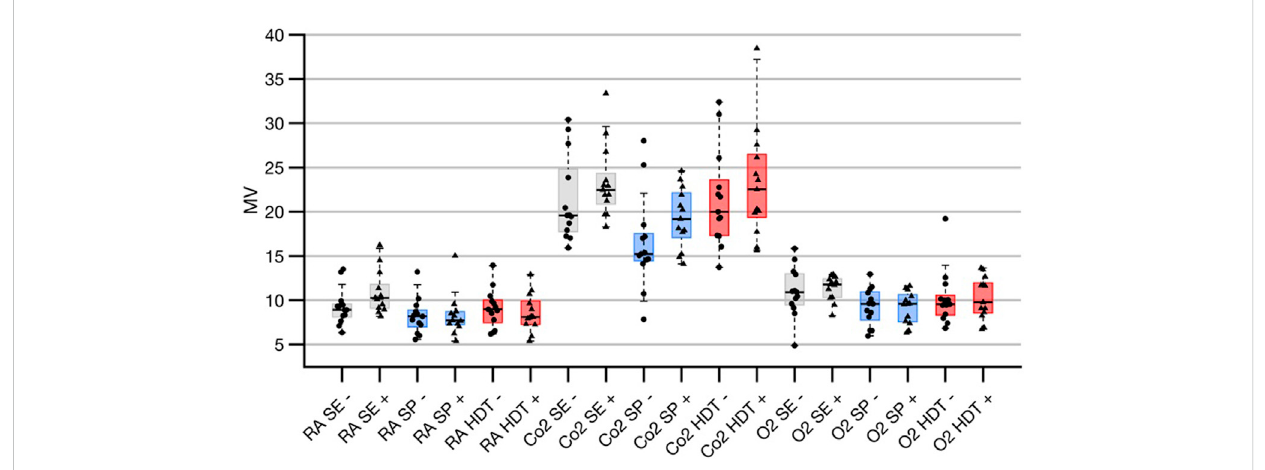
FIGURE 4 Results of 3-way ANOVA of minute ventilation derived from variation of three different factors, (A) TES (electrical stimulation on/off), (B) posture (seated, supine, HDT), and (C) inspired gas (room air, hypoxic and hypercapnic conditions). For further details of group assignments please refer to Supplementary Table S4. There was a signi fi cant interaction between factor b and c on minute ventilation. Data shown as median ±25 and 75% percentiles, behind individual data